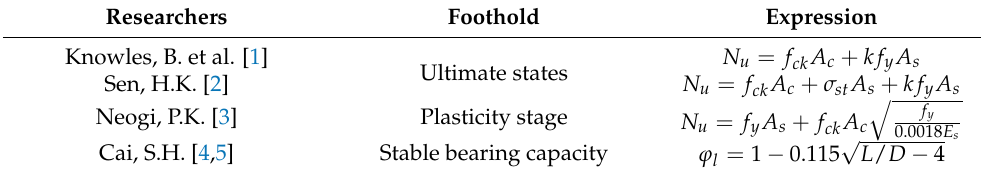
Table 1. Ultimate axial loading